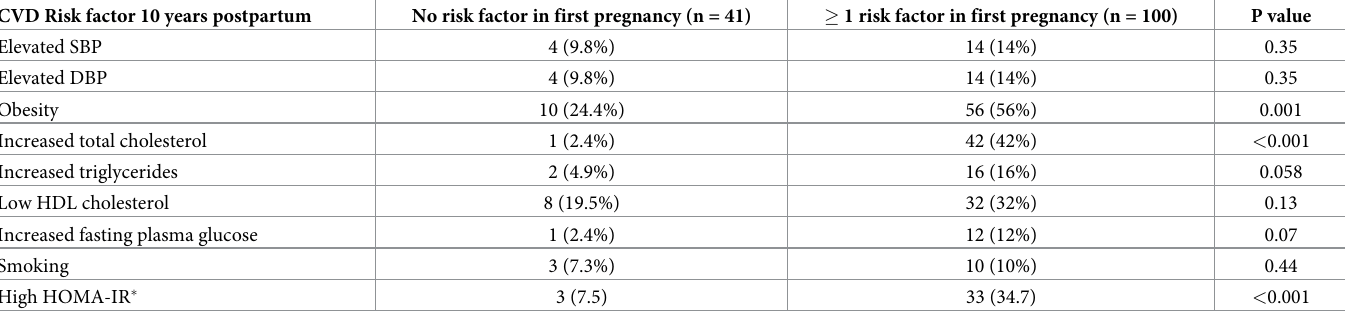
Results are number (%), � Insulin levels were available from 135 women. SBP, systolic blood 533 pressure; DBP, diastolic blood pressure; HDL, high density lipoprotein cholesterol, HOMA-IR, homeostatic model of insulin resistance. Categorical variables were compared using Chi-square test and the Fisher’s exact test. Continuous variables were compared using student’s t